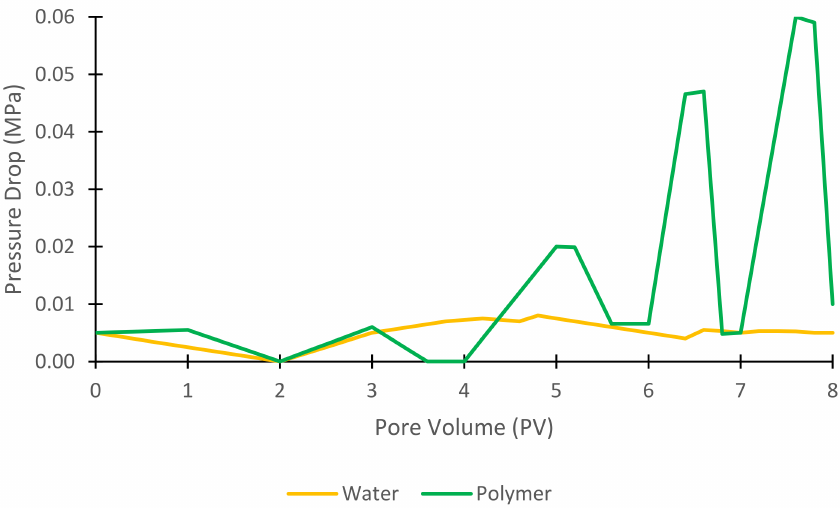
Figure 7. Pressure drop for water and polymer flooding in the absence of nanoparticles.